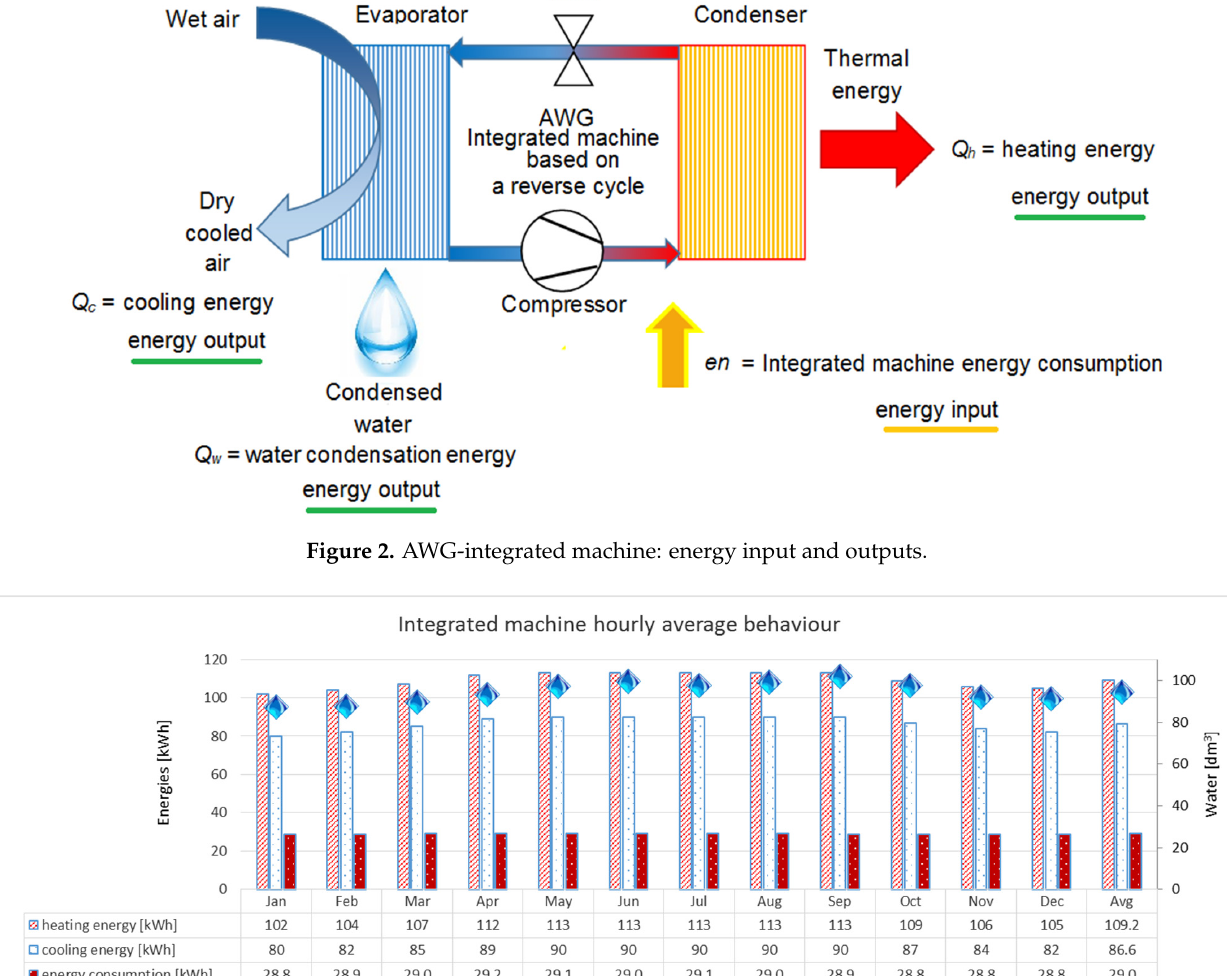
Figure 2. AWG ‐ integrated machine: energy input and outputs.